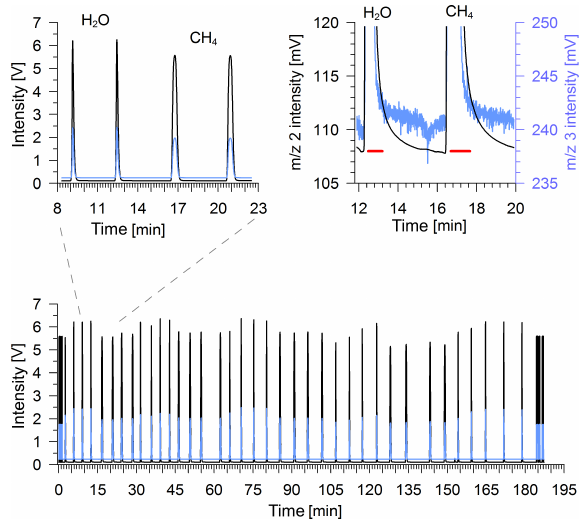
Figure 3. Chromatograms of δ 2 H–CH 4 calibration sequences us- ing TC/EA–IRMS with traces of m/z 2 and m/z 3 shown in black and blue respectively. The bottom panel shows an example of an entire calibration sequence which begins with three square-shaped peaks of pure H 2 , followed by alternations of three to four H 2 O- and three to four CH 4 -derived H 2 peaks before the sequence ends with another three square-shaped peaks of pure H 2 . The top left panel enlarges H 2 peaks from H 2 O (peak no. 6–7) and CH 4 (peak no. 8–9) injections respectively. A zoom into baseline details of H 2 O- derived peak no. 7 and CH 4 -derived peak no. 8 is shown in the top right panel. Red lines indicate the sections used for peak integration (weak widths are 43 and 59s for H 2 O- and CH 4 -derived H 2 peaks respectively) by the IRMS